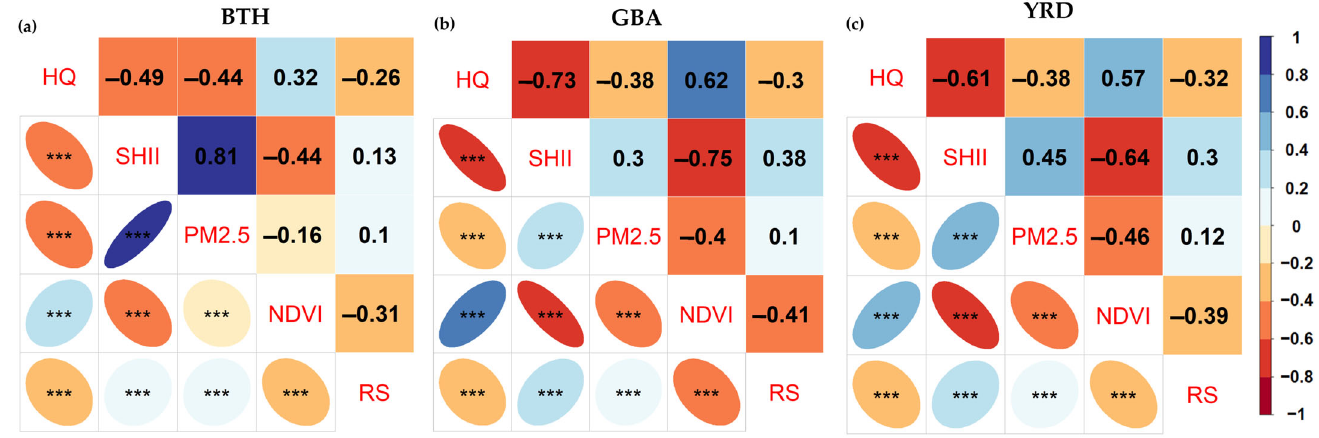
Figure 11. Correlograms of multifaceted environmental situations in the three UAs: ( a ) BTH, ( b ) GBA, and ( c ) YRD. Note: The asterisk symbols (‘***’) are representative of the statistical significance at the 0.1% level ( p < 0.001).